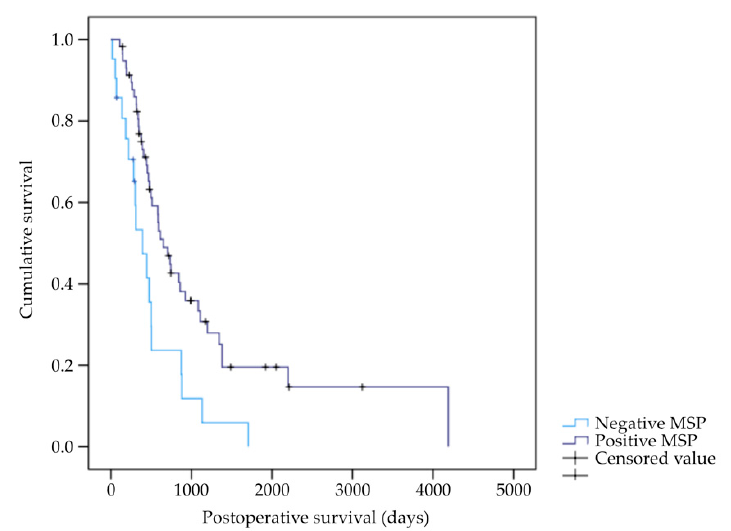
Table 2. Logrank test analysis results for median postoperative survival (days) according to